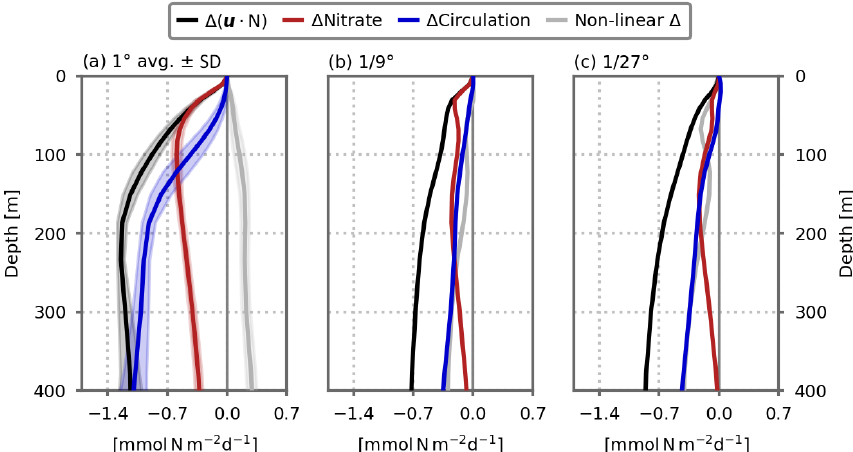
Figure 5. Role of circulation change versus nitrate distribution change in explaining the decline in the nitrate advection flux (mmolNm − 2 d − 1 ) in response to global warming in the model’s subpolar box, cumulated between the surface and depth D , for the (a) 1 ◦ , (b) 1 / 9 ◦ and (c) 1 / 27 ◦ resolution configurations. The black lines show the simulated change, which is decomposed into three components: the red lines show the component related to the change in nitrate distribution; the blue lines show the component related to the change in circulation; the gray lines show the residual due to non-linear changes. See Eqs. (3) to (6) for details. In (a) , the profiles show the average of the five 1 ◦ configurations. Shading indicates ± 1 standard deviation.